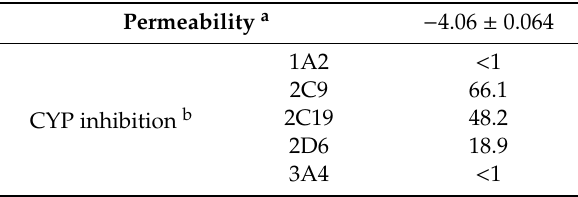
Table 3. Permeability and CYP inhibition of compound 8